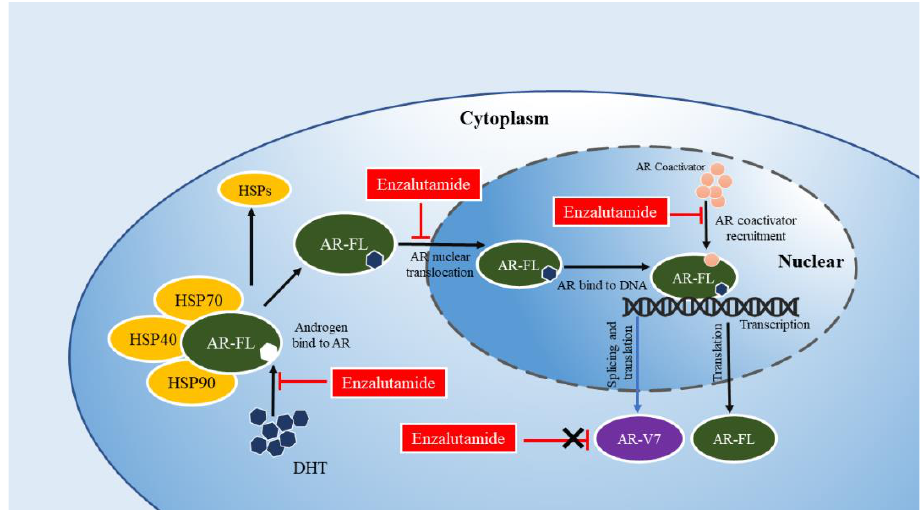
Figure 2. Enzalutamide acts on the AR signaling pathway. Enzalutamide binds to the LBD and blockades the AR signaling pathway by blocking the binding of androgens to AR, impeding the AR nuclear translocation, and inhibiting the AR transcriptional activity. AR-FL: full-length androgen receptor; AR-V7: androgen receptor splice variant 7; DHT: dihydrotestosterone. HSP: heat shock proteins.